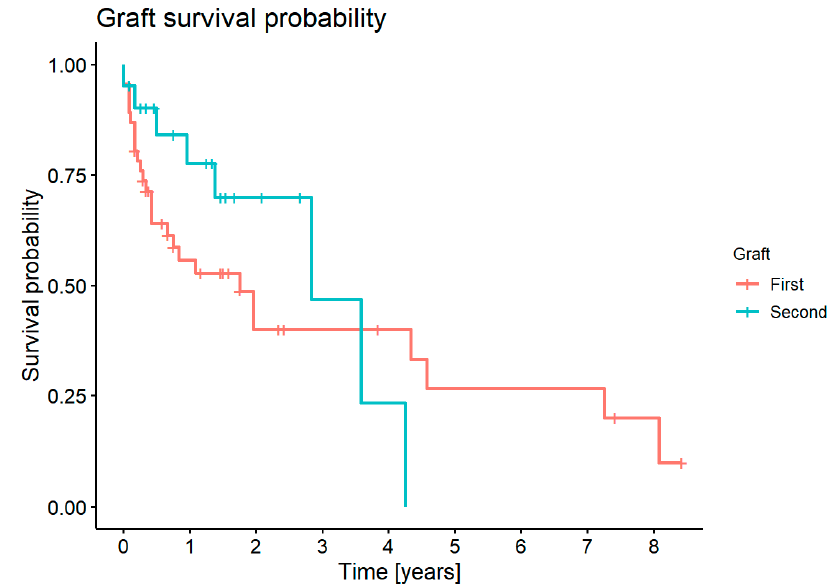
Figure 13. Graft survival probability for the first and second keratoplasty.